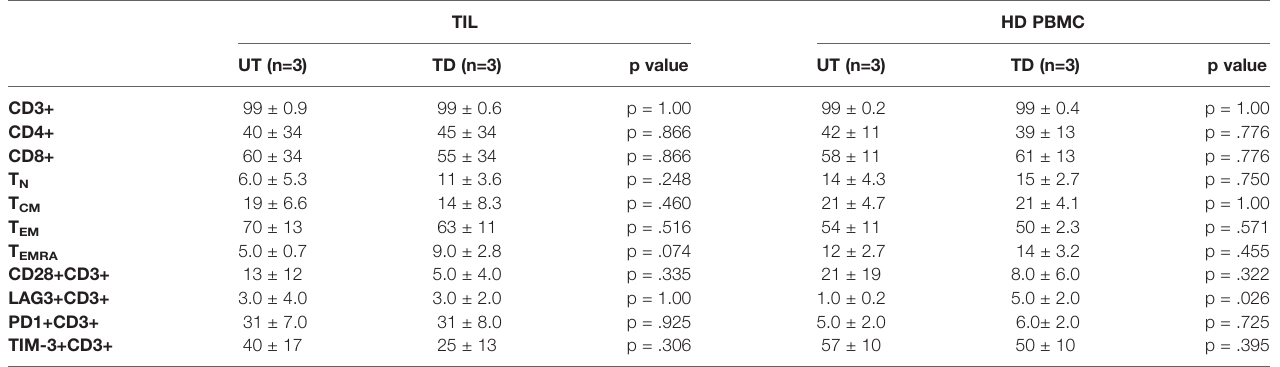
TABLE 1 | Phenotypic pro fi le of untransduced (UT) vs. transduced (TD) TIL and HD PBMC on day 9 of SCP. Data are presented as average % expression of the indicated markers. TIL HD PBMC